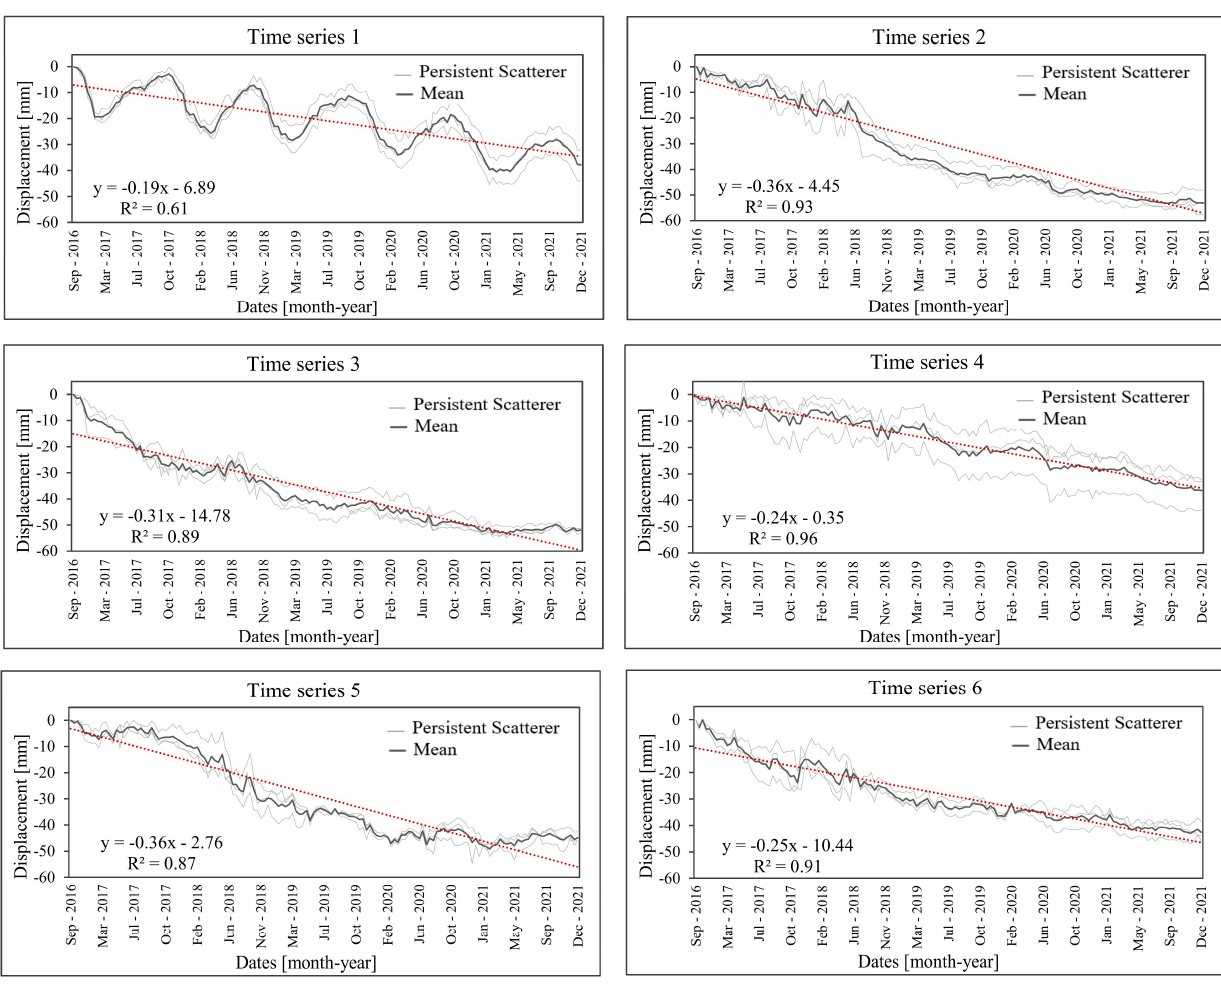
Figure 8 . InSAR 1–6 time series, from September 2016 to December 2021, from 145 Sentinel 1 acquisitions, gray line represents Persistent Scatterers, and black line the mean.